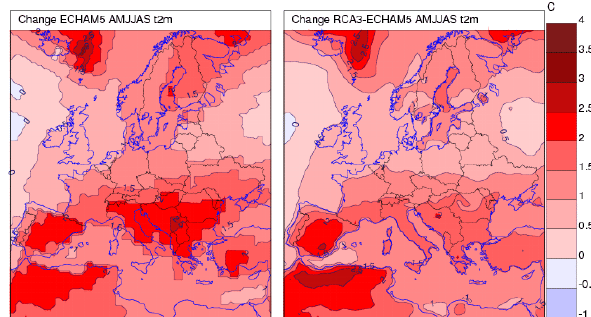
Fig. 4. Temperature change between the periods 2000–2009 and 2040–2049 for April–September simulated with ECHAM5 A1B-r3 (left) and downscaling of the same simulation with RCA3 (right). Units: ◦